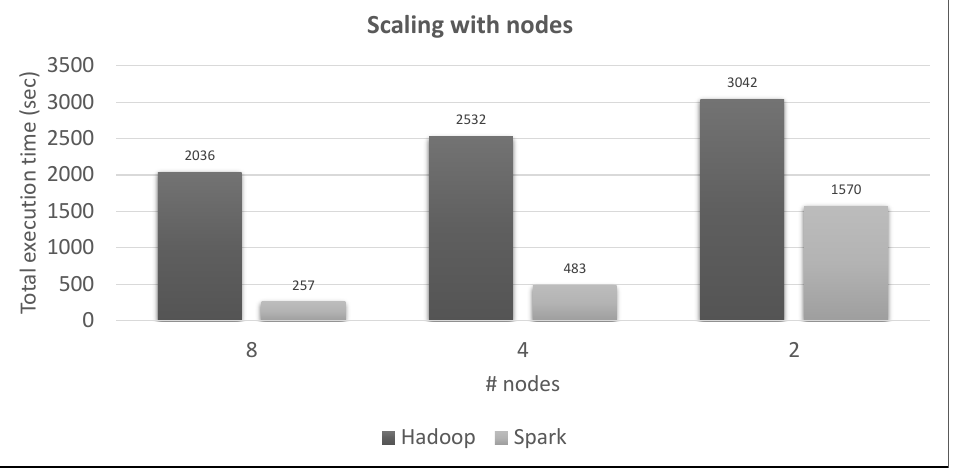
Figure 30. Spark vs. Hadoop scaling with number of nodes, hydro (new loc.) query vs. large training